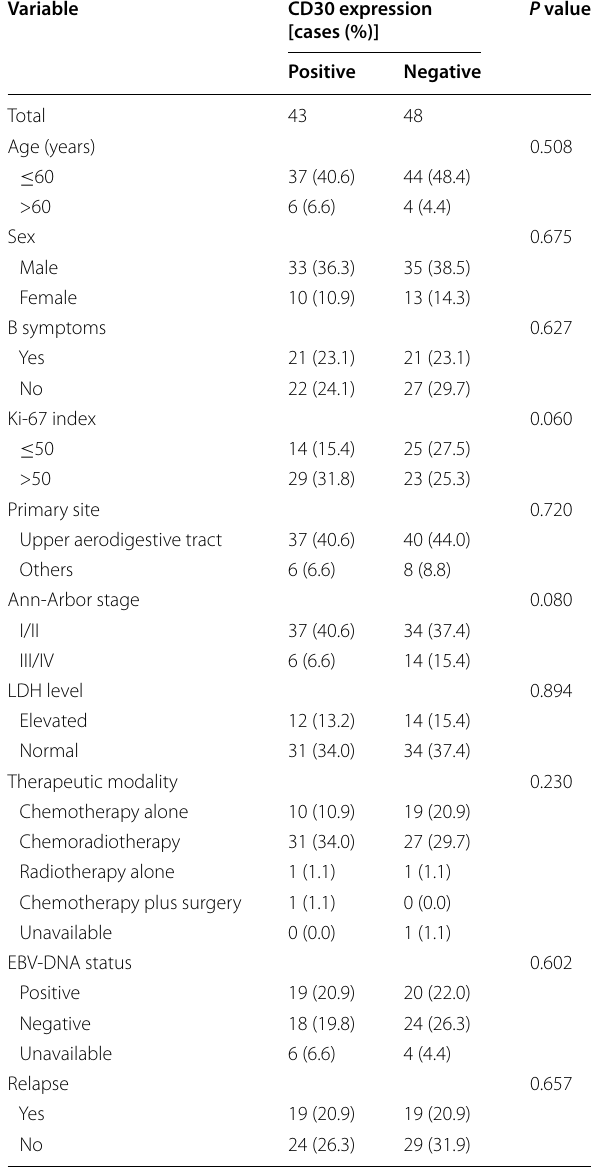
LDH lactate dehydrogenase, EBV Epstein-Barr virus